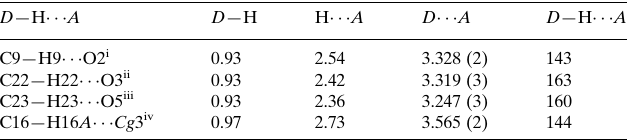
Hydrogen-bond geometry (A˚ , (cid:2) ). Cg 3 is the centroid of the C7–C12